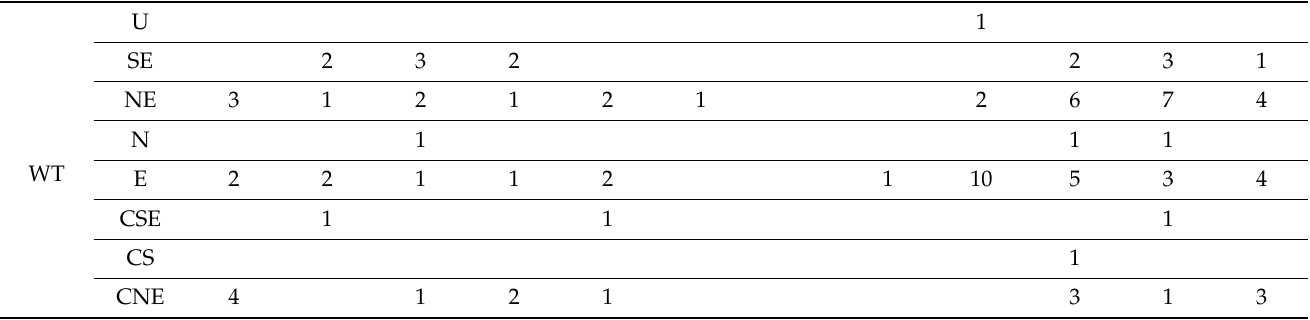
Table 7. Monthly absolute frequencies according to the classification by J&C